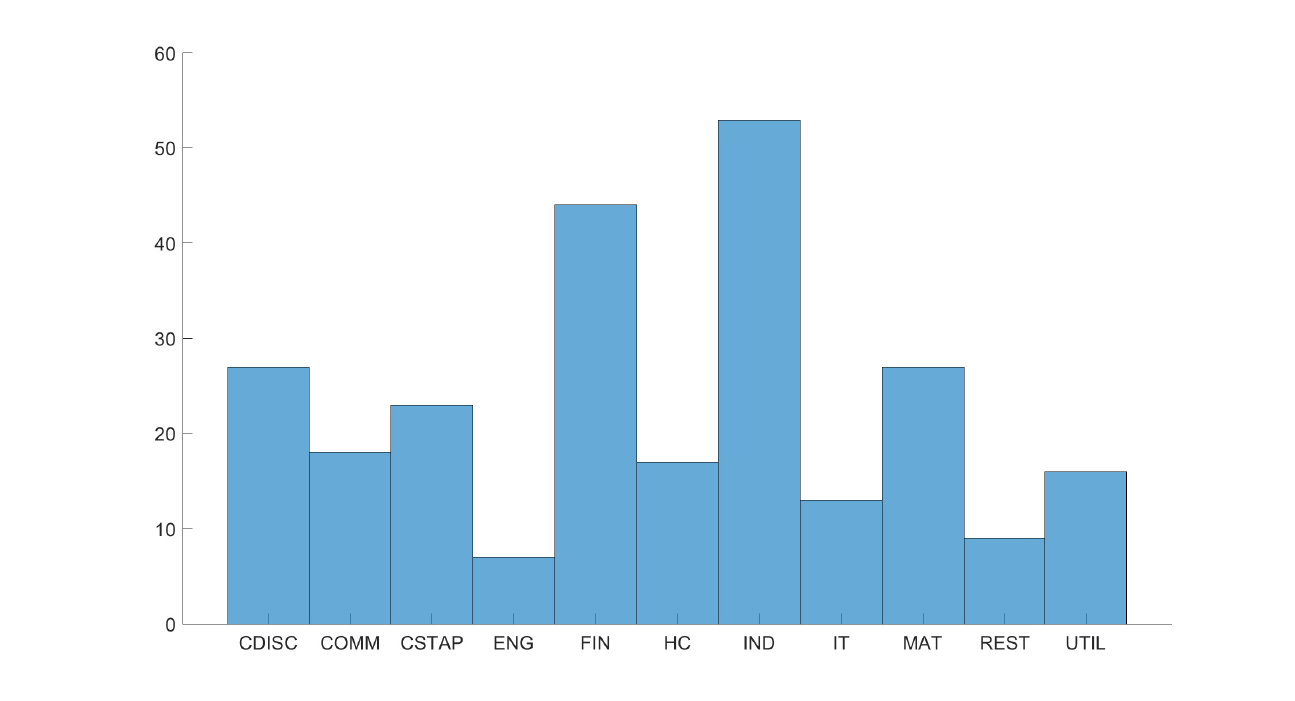
Figure 2. The number of firms in each sector in our dataset. Source: Authors’ calculations.